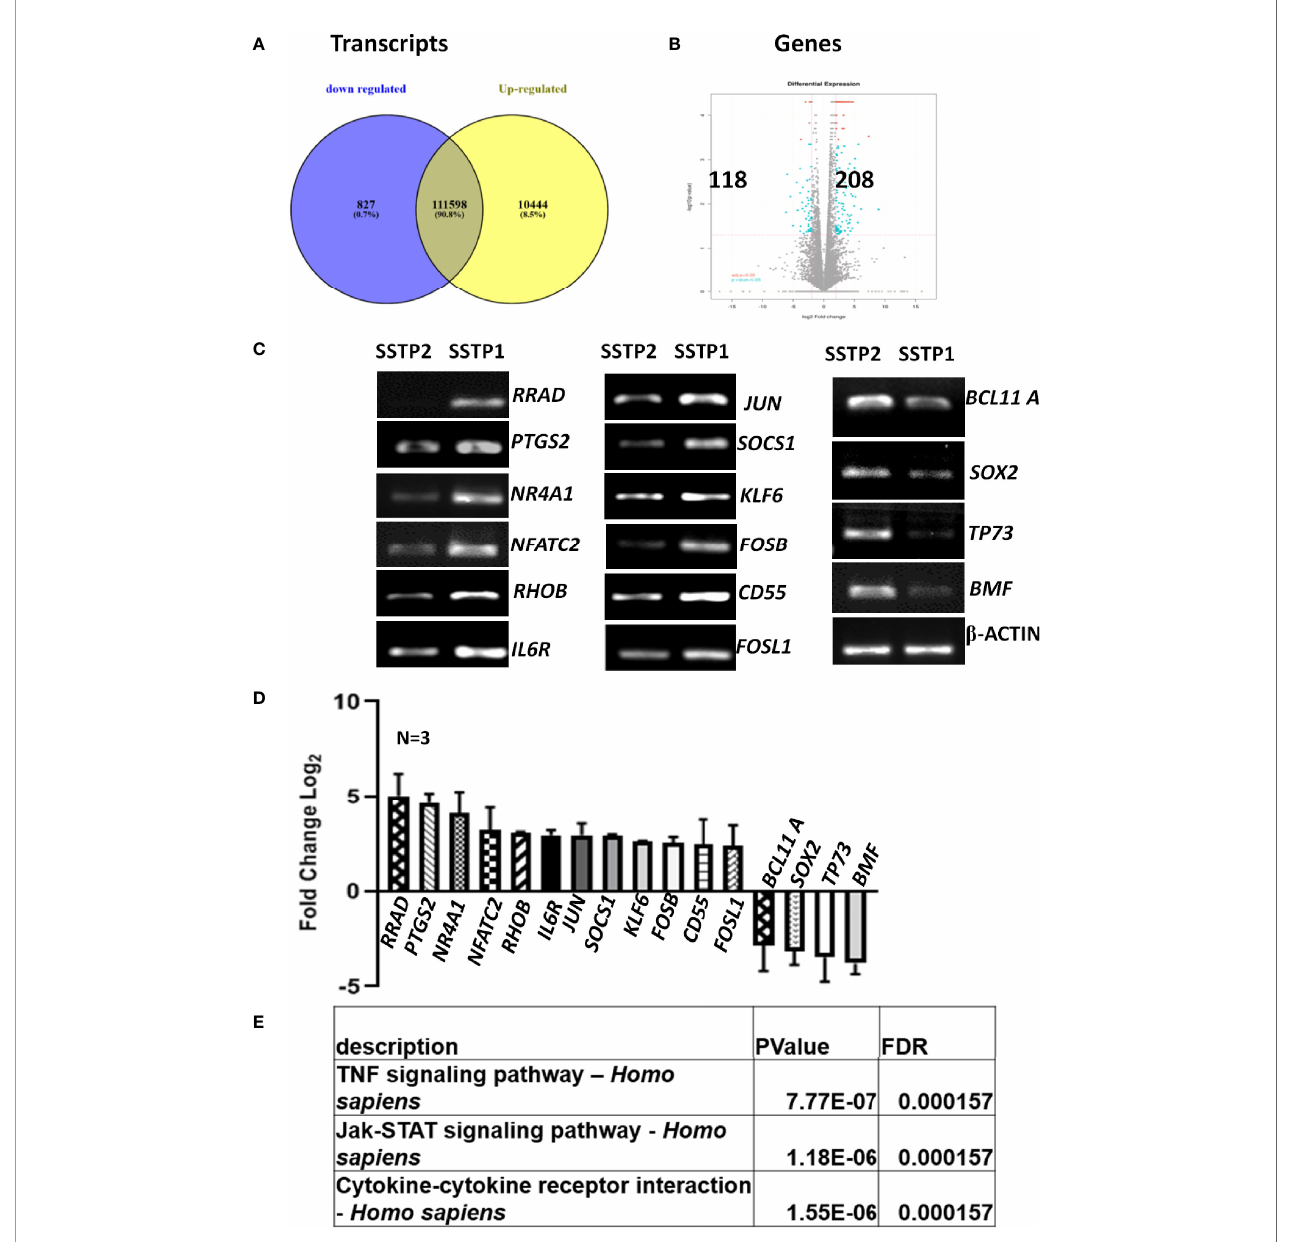
FIGURE 3 | RNA-Seq analysis suggests the activation of cytokine signaling pathway upon SSTP1 treatment. (A) HSC-4 cells were treated with 10 m M SSTP1 and SSTP2 for 3h, and total RNA was isolated to perform RNA-Seq analysis. The Venn diagram represents the differential expression of transcripts upon SSTP1 treatment compared to SSTP2-treatment. (B) Volcano plot showing differential expression pro fi le of genes showing signi fi cant up regulation and down regulations on treatment with SSTP1 with respect to control peptide SSTP2. Red dots indicate absolute log2 fold change ≥ 2 and FDR- adjusted p value ≤ 0.05 and blue dots indicate log2 fold change ≥ 2 and p value ≤ 0.05. (C, D) The results were con fi rmed by RT-PCR and qPCR for the indicated molecules. (E) A pathway enrichment analysis was performed based on the differential gene expression analysis, and top 3 pathways that were regulated are